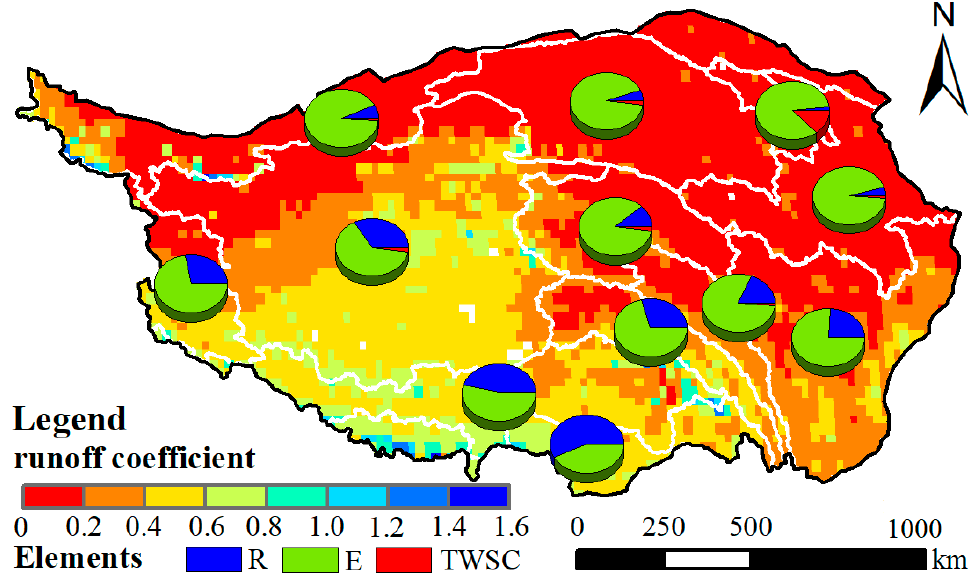
Figure 9. Regional statistical diagram of the proportions of each hydrological cycle’s elements in precipitation and spatial distribution of runoff coefficient over the Tibetan Plateau.